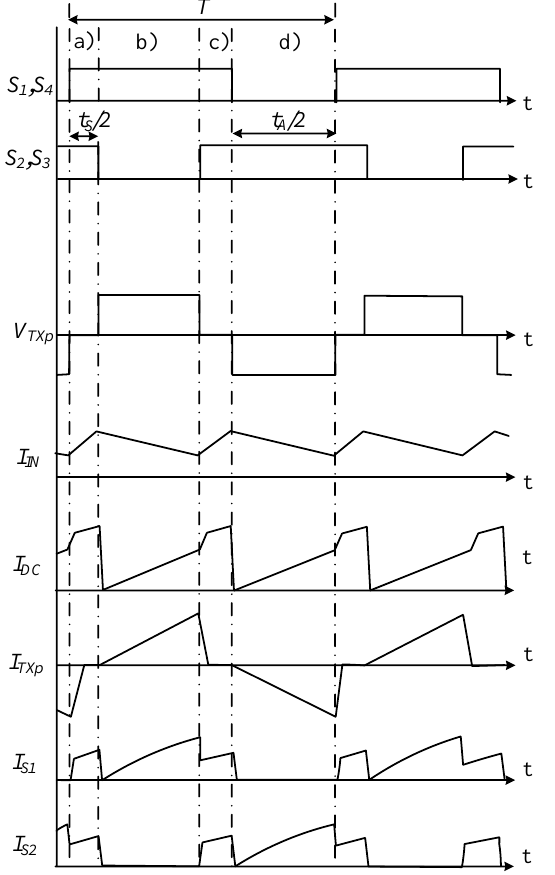
Fig. 3. Generalized waveforms of the qZS full-bridge DC-DC converter. - a) and c) are the shoot-through intervals. All four inverter stage switches are conducting, the boost inductor L IN is accumulating energy, the clamping switch S CL is turned off;